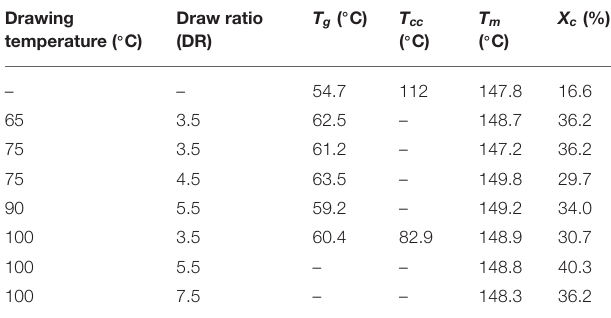
TABLE 1 | Thermal parameters for the undrawn PLA filament and the filaments drawn at different drawing conditions. Drawing temperature ( ◦ C)